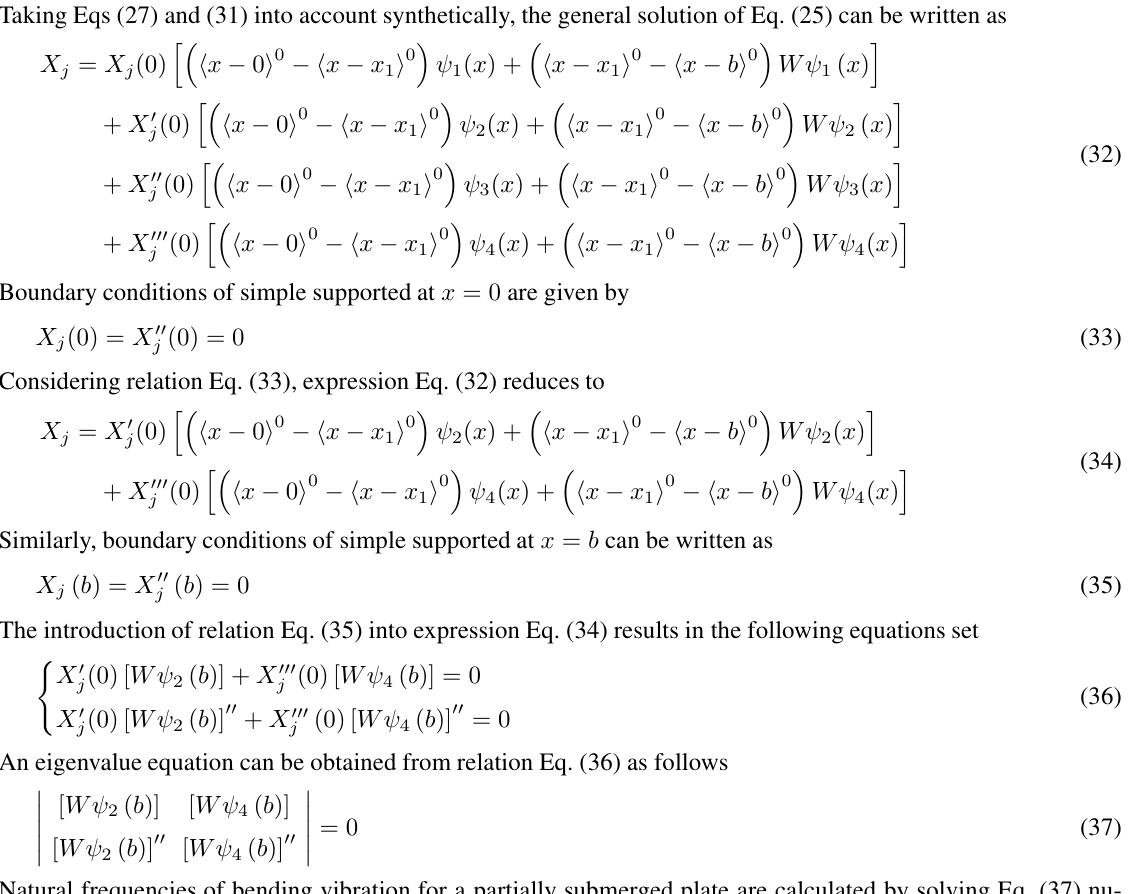
Fig. 5. Variations of natural bending frequencies with